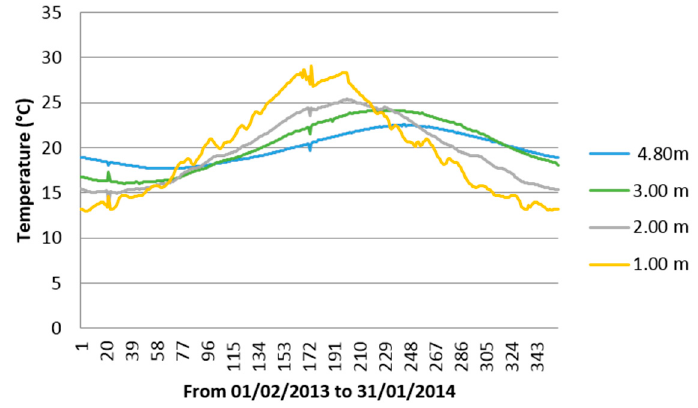
Figure 12. Average daily temperatures at different depths from 1 m to 4.8 m.